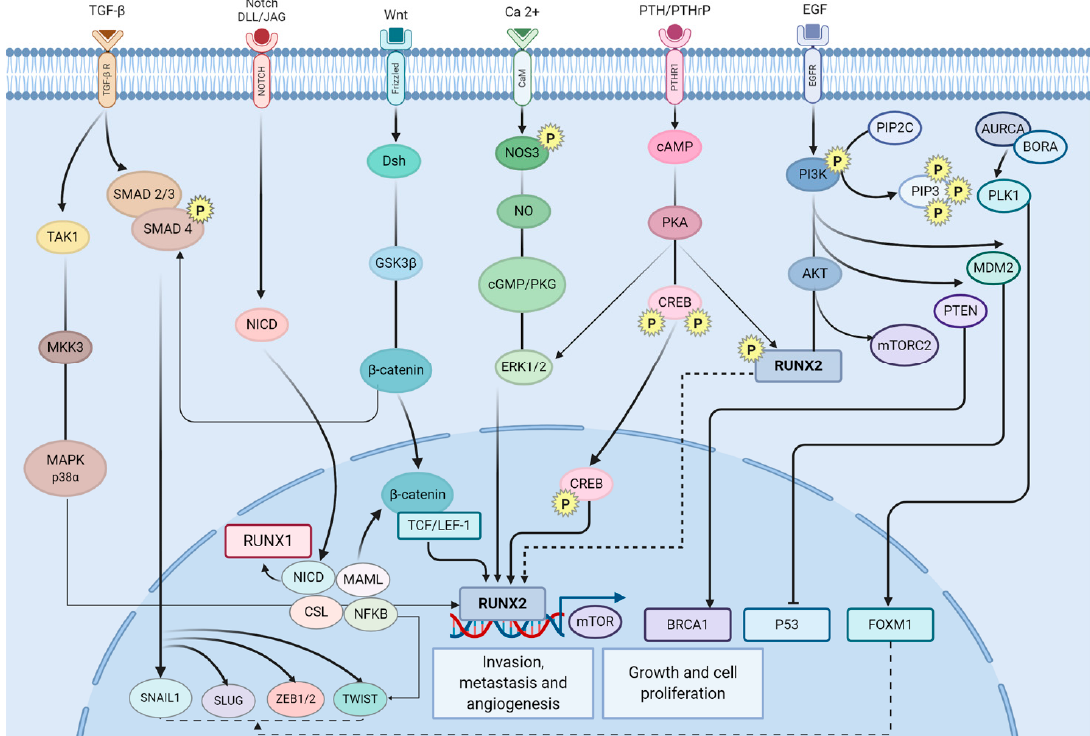
Figure 4. Transcriptional regulators in lung cancer and their association with the acquisition of the hallmarks of cancer and the signaling pathways associated with the establishment and progression of lung cancer. Figure adapted from Figure 1 in Ref. [57], Figure 2 in Ref. [58], Figure 5 in Ref. [59], Figure 3 in Ref. [60], Figure 1 in Ref. [61], and Figures 1 and 3 in Ref. [62]. The databases identified 156 possible RUNX2 target genes, some of which are signif ‐ icantly associated with transcriptional dysregulation in cancer, proteoglycans in cancer, angiogenesis, and tumor cell growth, as well as the acquisition of cancer characteristics [63], suggesting their importance in the establishment and progression of lung tumors. Some RUNX2 target genes are associated with two signaling pathways. The Hippo sig ‐ naling pathway inhibits the YAP and TAZ transcriptional coactivators by phosphoryla ‐ tion, while the TGF ‐ beta signaling pathway positively regulates TAZ, which interacts with RUNX2 by coactivating it to promote cell differentiation in mesenchymal stem cells [64] and thus induces a tumor phenotype [65], while YAP can act as an inhibitor of RUNX2 [66]. NOTCH1 binds to RUNX2 to directly inhibit it and upregulates CDK4, which ubiq ‐ uitinates and degrades RUNX2 [67], thereby controlling the lineage specification [68]. The participation of RUNX2 in signaling pathways associated with stem cell pluripotency sug ‐ gests the participation of this TF in the differentiation of tumor stem cells (CSCs) towards tumor cells (CCs) in specific tissues. The RUNX family of transcription factors forms a heterodimeric complex with CBF β , which increases its DNA binding affinity by exposing its DNA binding domain [69]. RUNX2 forms a complex with p53 and histone deacetylase 6 (HDAC6) in the cell nucleus following DNA damage, inhibiting transcriptional and pro ‐ apoptotic activity [70]. Zfp521 is a binding partner of Runx2 during the early stages of osteoblast differentiation [71]. The MEF and Runx2 proteins form a complex, which interferes with Runx2 binding to the cis ‐ acting element OSE2, promoting cell proliferation and inhibiting osteogenic